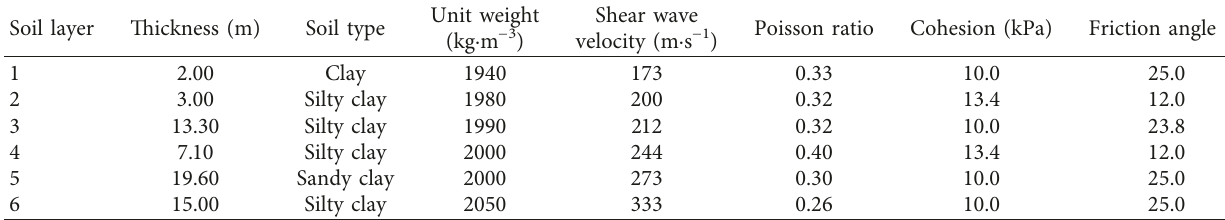
Table 4: Soil physical properties for site III.